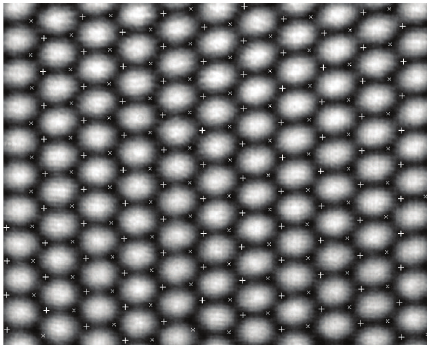
Figure 2: The Intensity distribution of the interference field obtained by three-plane waves (experiment). The position of vortex points is marked by plus signs or crosses to distinguish between two di ff erent topological